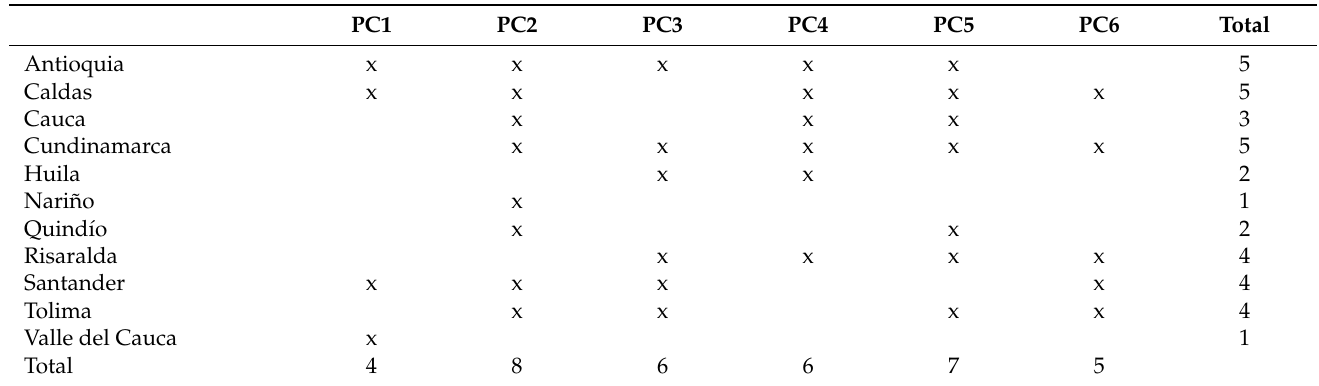
Table 3. Summary of departments that have the largest contribution to the first six PCs (princi- pal components).